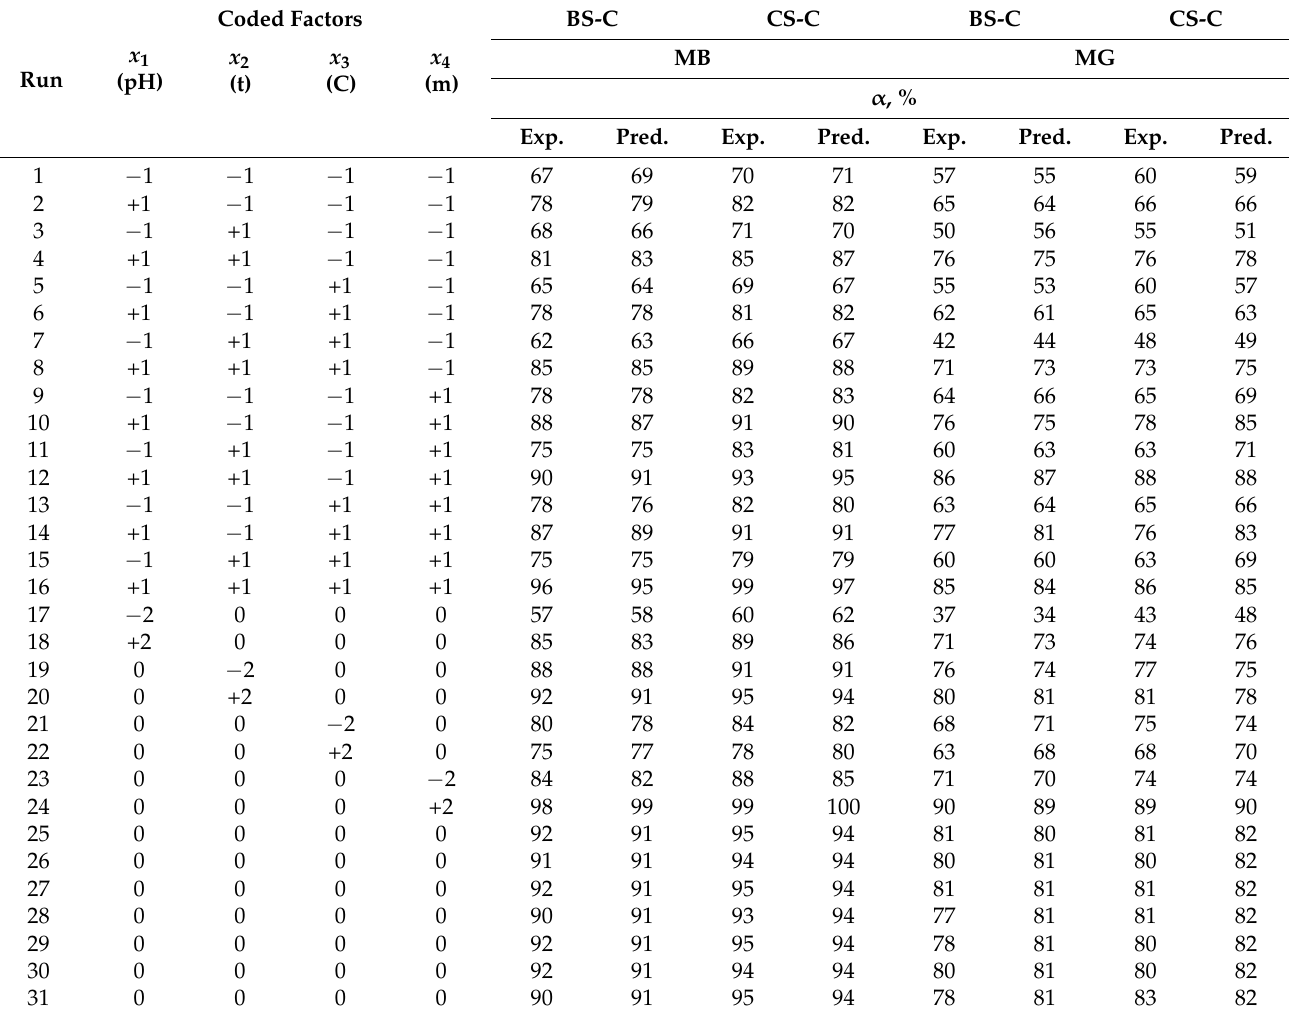
Table 4. Experimental and predicted results of the CCD model for the cationic dyes adsorption on BS-C and